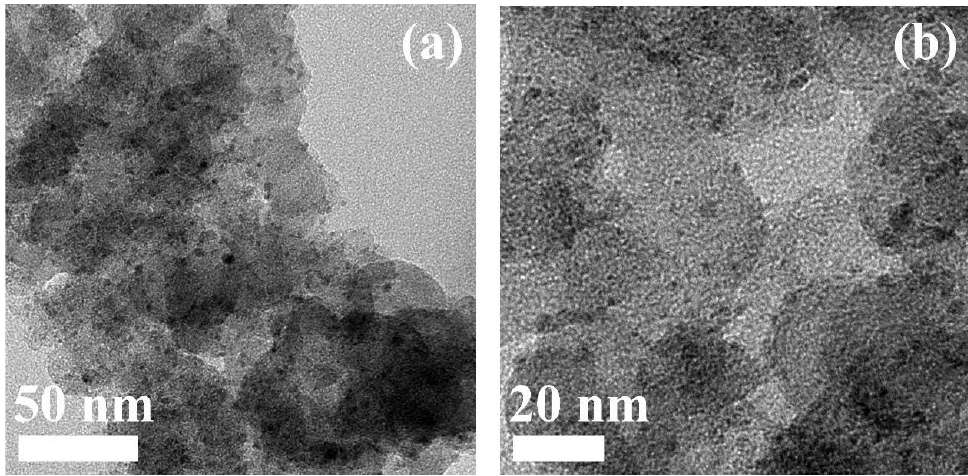
Figure 4. ( a ) Hydrogen evolution reaction (HER) polarization curves of Ru 2 P-BM-C and benchmark Pt/C, respectively. ( b ) Tafel plots of corresponding Ru 2 P-BM-C and Pt/C. ( c ) Polarization curves of the Ru 2 P-BM-C catalyst decorated on a GC electrode before and after 2000 CV cycles. All tests were performed in 1 M KOH.